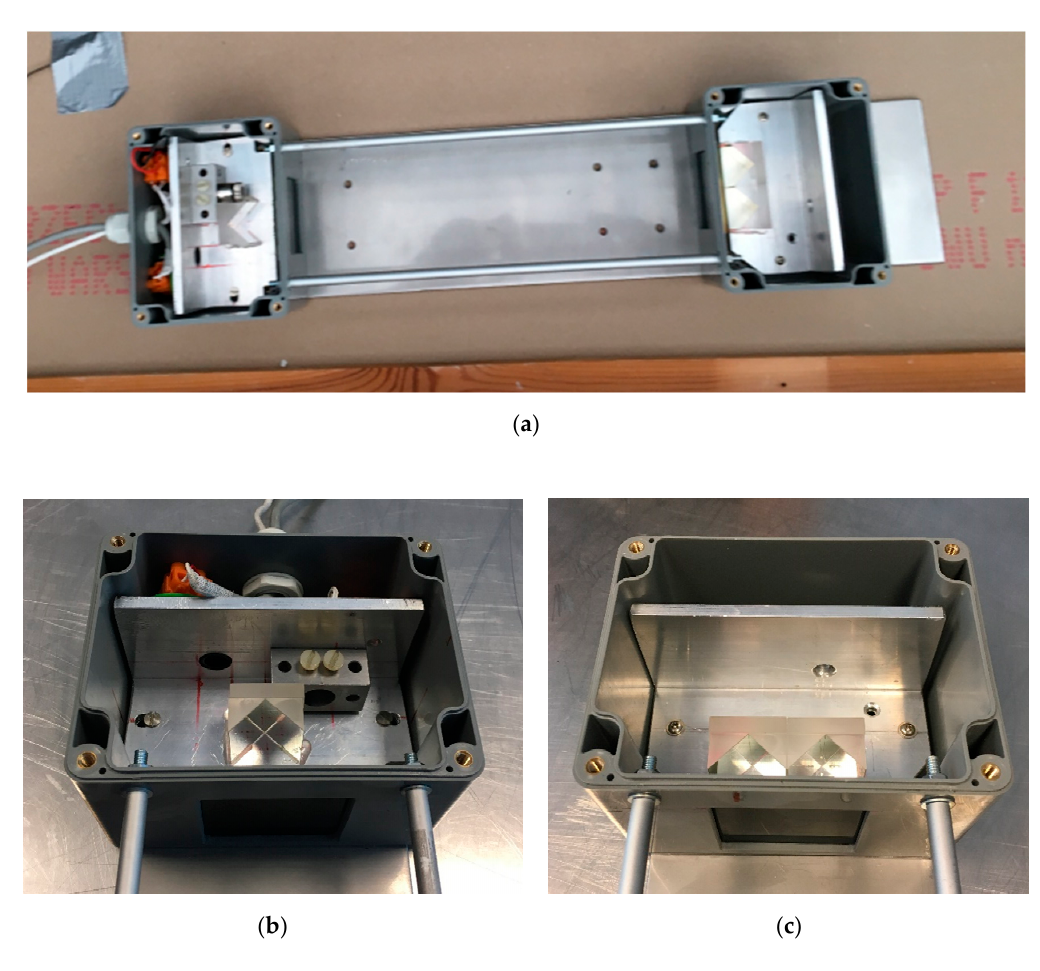
Figure 5. The final prototype of the optical densitometer for reduced-scale fire experiments. ( a ) Overview of the device; ( b ) close up of the laser-photodiode component; and ( c ) close up of the reflecting component.